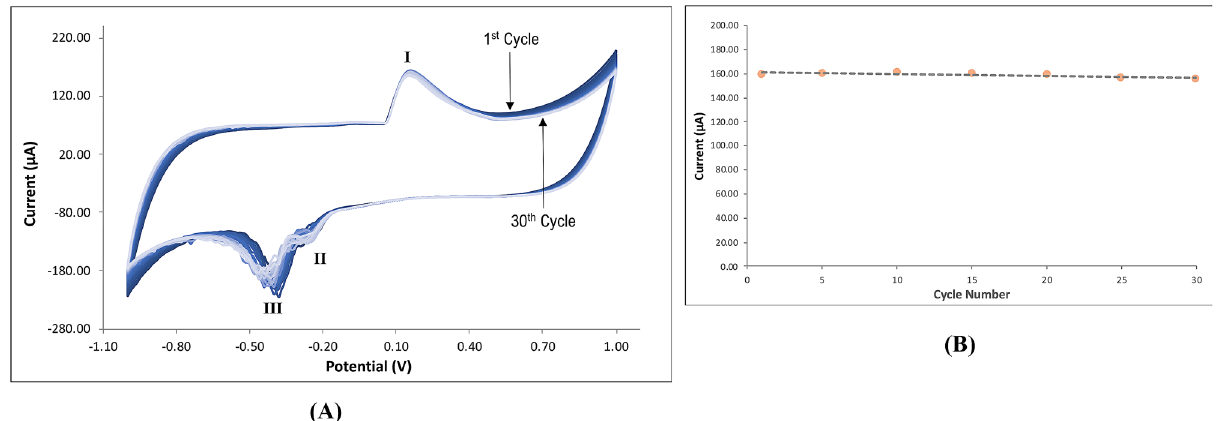
Figure 12. ( A ) Cyclic voltammogram of the modified SPGE for 30 cycles. ( B ) Peak I current vs. the number of cycles.